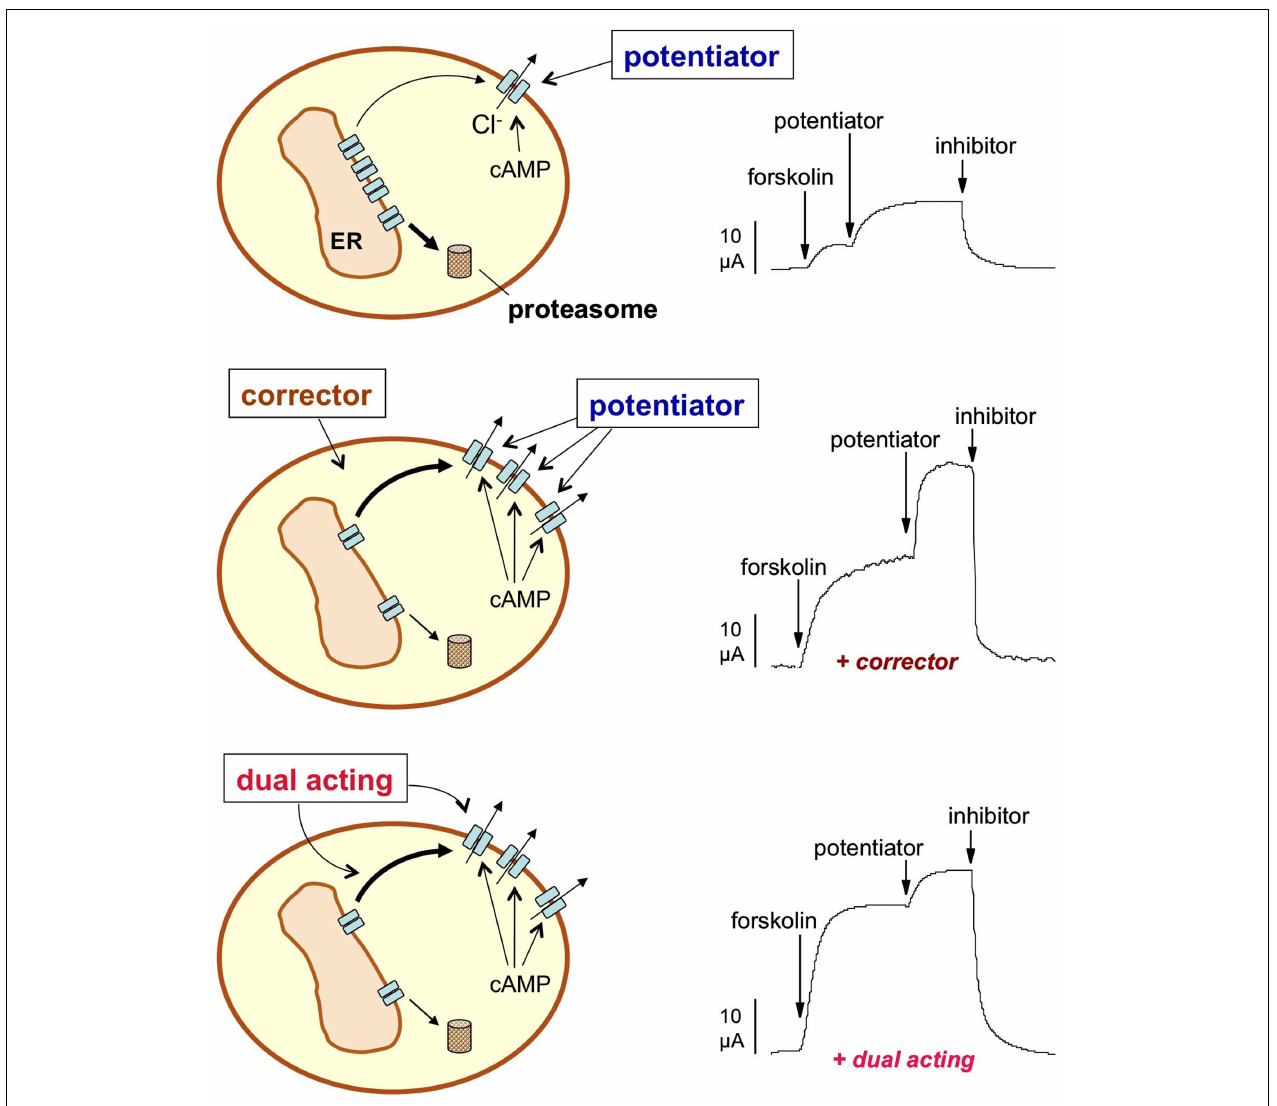
agent (forskolin) and then further increased with a potentiator, a compound that corrects the intrinsic channel gating defect caused by ∆ F508. Finally, a CFTR inhibitor is used to measure the total Cl − current dependent on CFTR. Incubation with a corrector enhances the total current (middle trace) due to the increase in the number of CFTR channels in the PM. A dual-acting compound (bottom trace) not only increases the total current but also the fraction of the current that is elicited cAMP alone thus minimizing the requirement for a